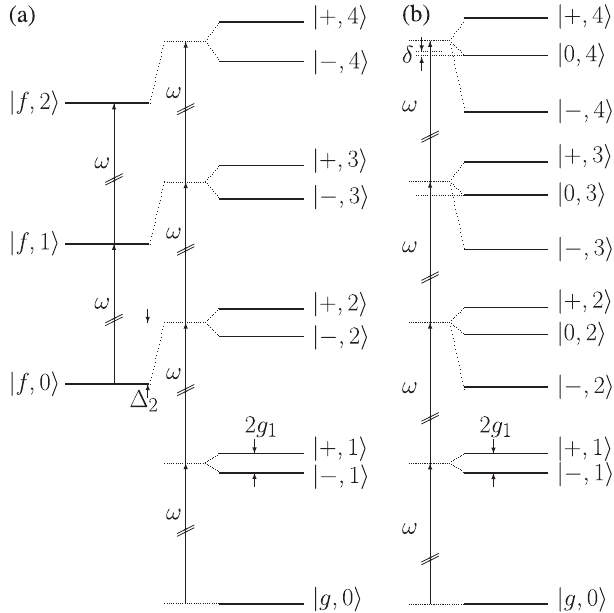
FIG. 2. (a) The spectrum of the coupled atom-cavity system if the third atomic state j f i is only weakly coupled to the middle one j e i ; that is, g 2 ≪ g 1 . In (a), the j(cid:3) ; n i denote the usual two- level atom JC model dressed states which combine the states j g; n i and j e; n − 1 i . (b) The spectrum of the coupled atom-cavity system in the experiment is Δ 1 ¼ 0 , Δ 2 ≃ E In (b), the multiplets jf − ; 0 ; þg ; n i correspond to the eigenstates of Eq. (1) in the manifold of a number of n excitations. δ represents the mismatch of ω with respect to the transition frequency between the states j 0 ; 3 i and j 0 ; 4 i , which is still an order of magnitude larger than the linewidth for these inter- mediate photon